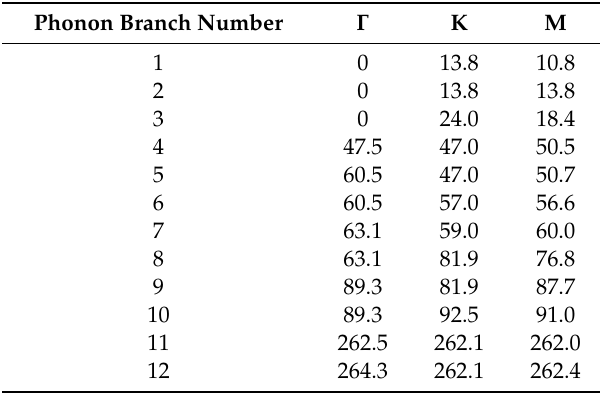
Table 2. Silicane phonon energies (meV) at Γ, K, and M.